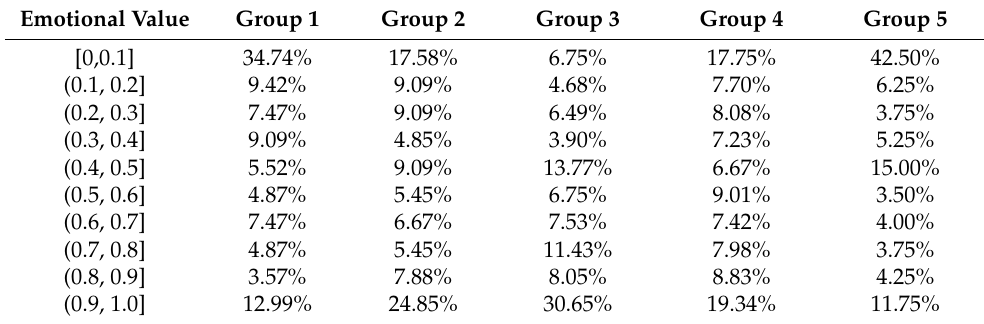
Table 7. User group sentiment value